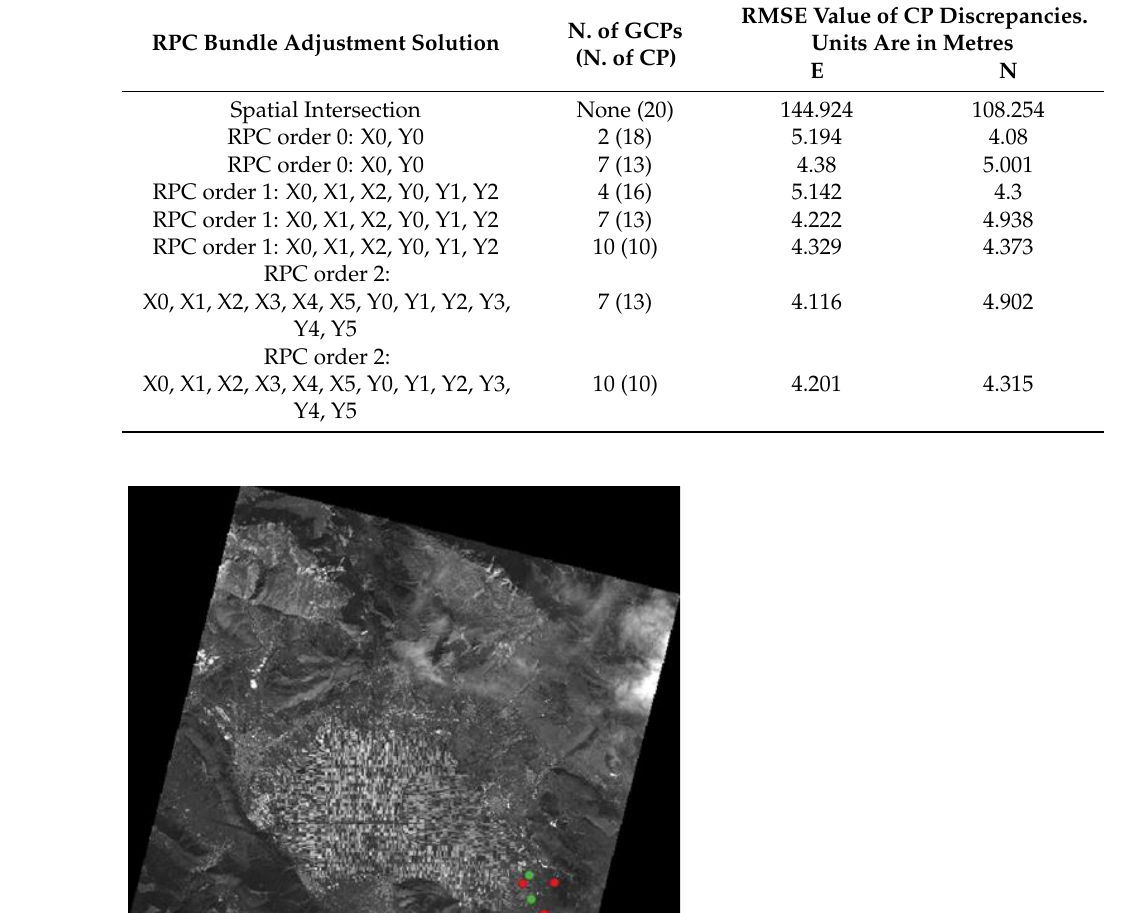
Table 9. Results of RPC bundle adjustment with bias compensation for small-central area of Fucino.